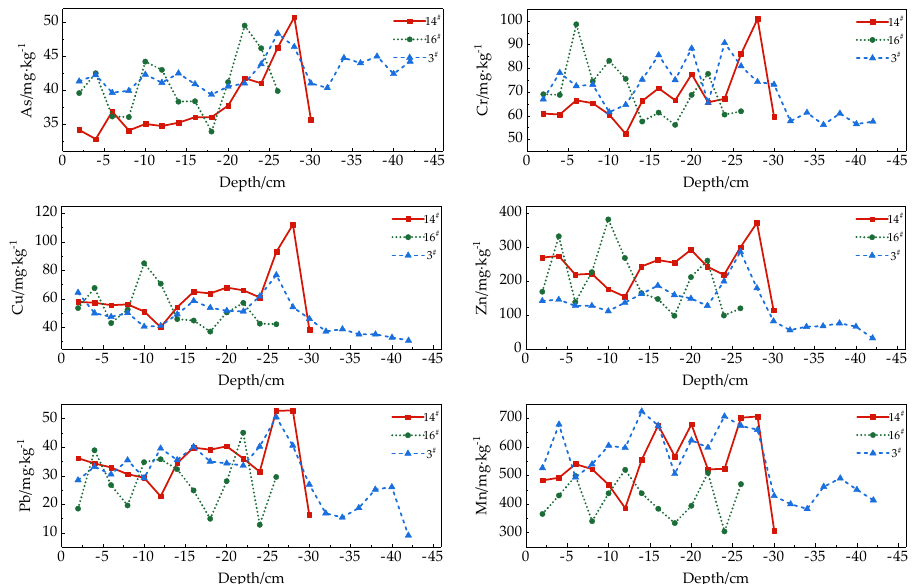
Figure 3. Vertical distribution characteristics of HMs in